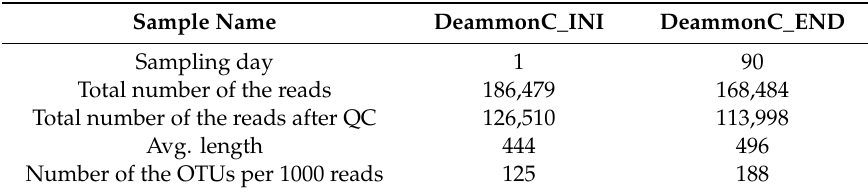
Table 2. Summary of the 16S rRNA gene Illumina NGS analysis.